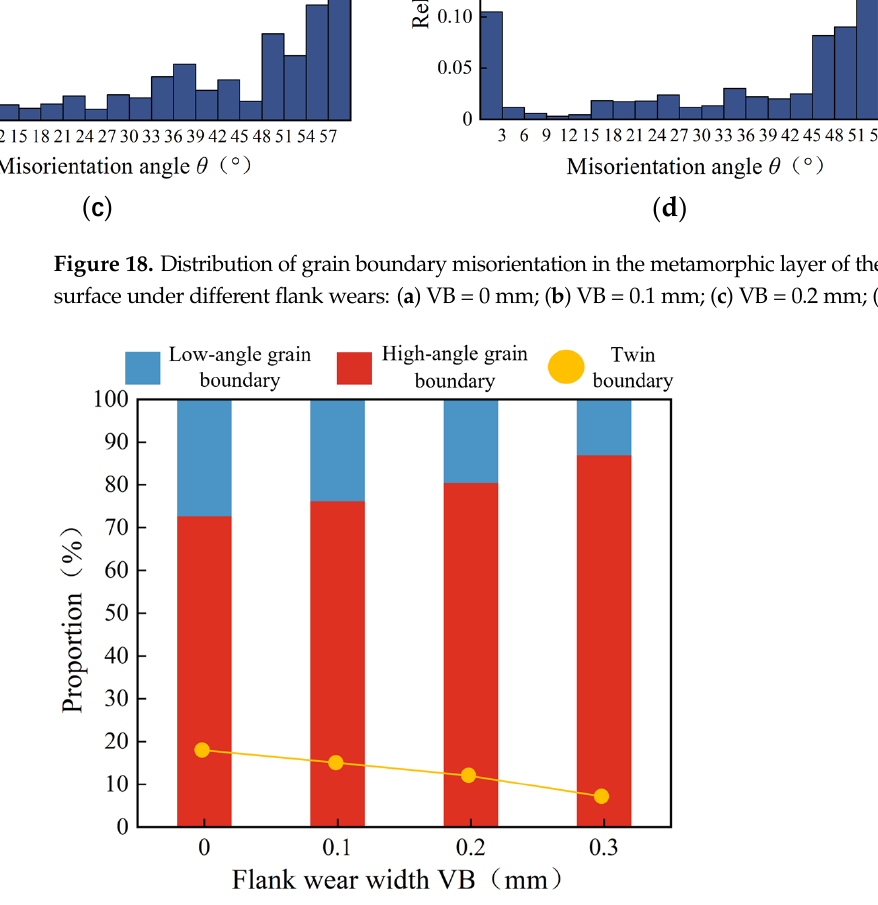
Figure 19. Proportion of high-low angle grain boundaries and twin grain boundaries under different flank wears.